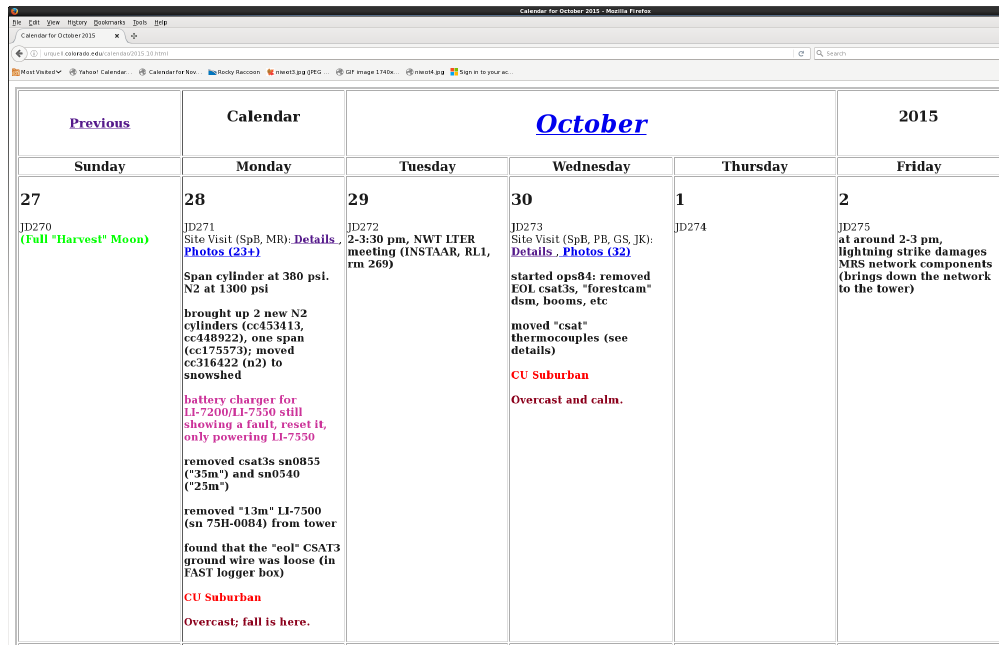
Figure 4. A screenshot example of the US-NR1 web calendar from October 2015. The web calendar includes a color-coded short summary of activities done at the site as well as links to photos and a more detailed logbook entry of the visit. The web calendar is accessible online at http://urquell.colorado.edu/calendar/.